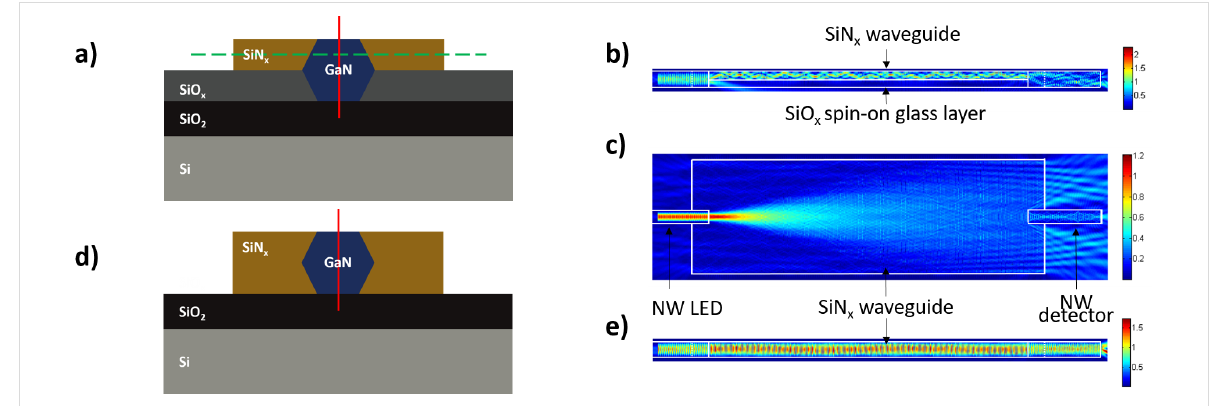
Figure 2: (a) Front-view cross-section schematic showing the cutting positions for 2D simulated cross-sections in panels (b) and (c); Electric field dis- tributions for a (b) vertical and (c) horizontal cross-section taken at the middle of the waveguide (cutting position corresponding to the solid red line and dashed green line in (a)). Waveguide width is 10 µm. (d) Front-view cross-section schematic of the platform without spin-on glass encapsulating layer showing the cutting position for cross-section of panel (e). (e) Influence of the spin-on-glass layer: electric field distributions in the vertical cross- section layer in the middle of the waveguide without spin-on glass encapsulating layer (cutting position corresponding to red solid line in panel